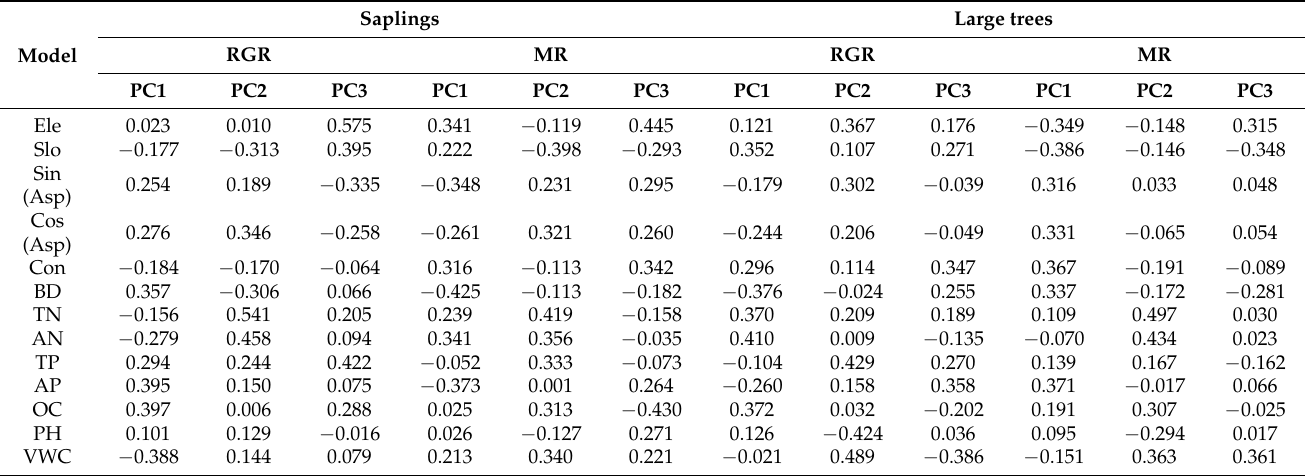
Table 4. Result of coefficients of principal component analysis for topographical and soil characteris- tics of RGR and MR in saplings and large trees.